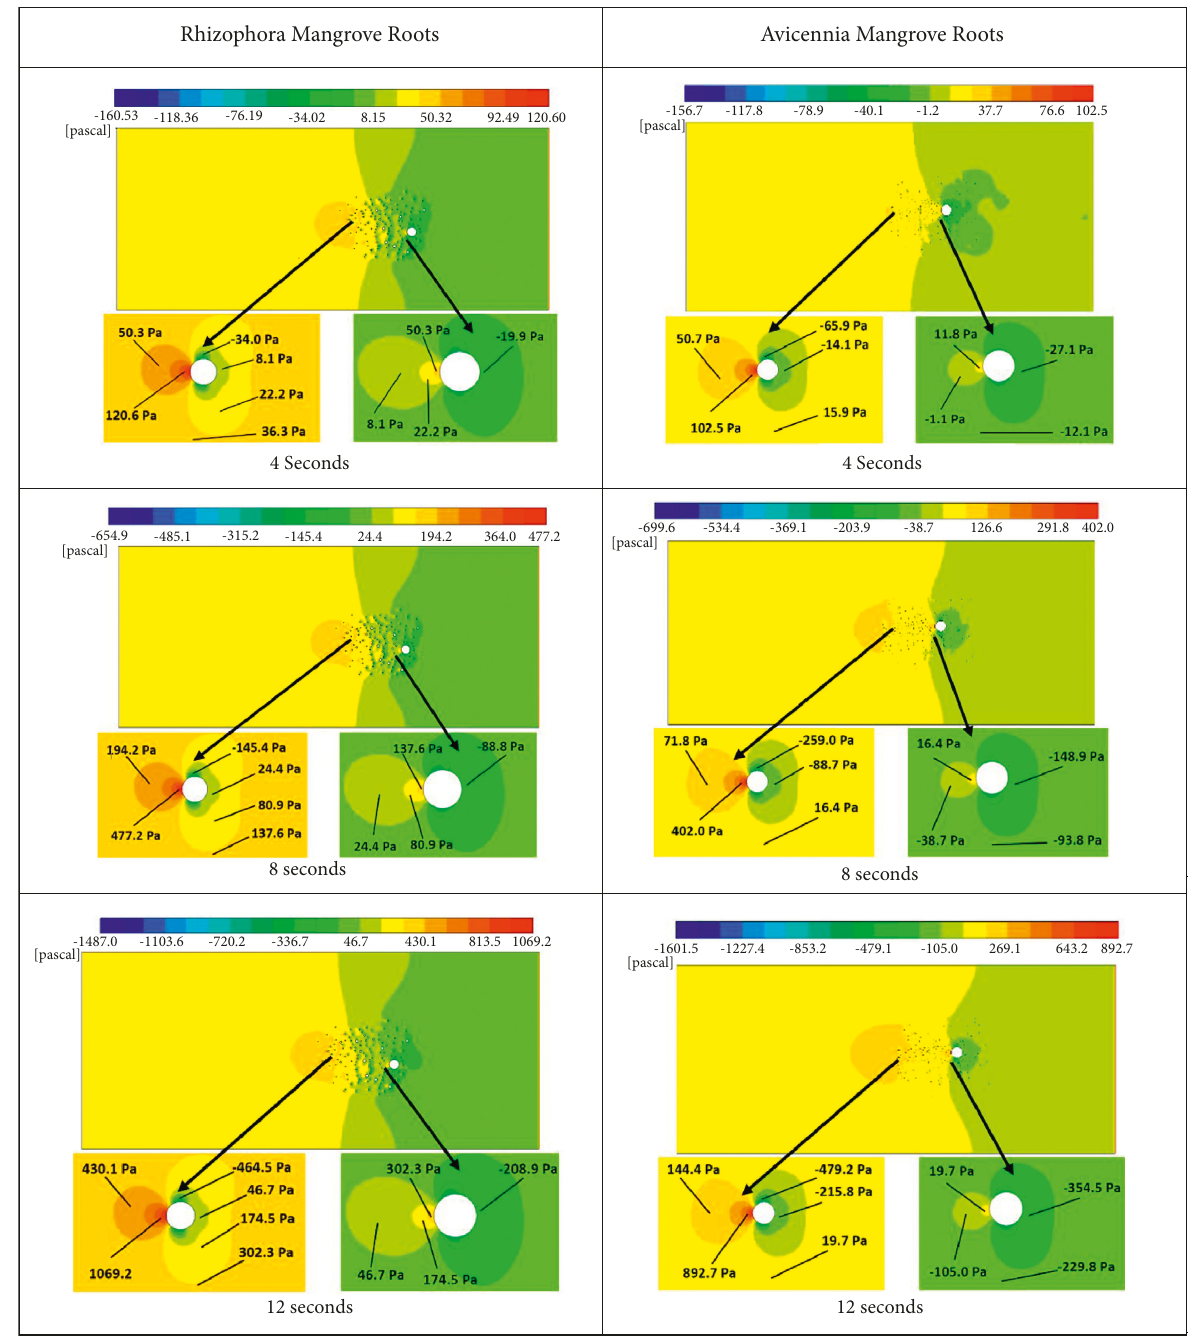
Figure 10: Static pressure distribution of incompressible unsteady air flow at time intervals of 4 seconds, 8 seconds, and 12 − 26.6 Pa, − 91.7 Pa, and − 250.3 Pa (green contour) and − 0.5 Pa, − 35.7 Pa, and − 50.5 Pa (light green contour). Table 5 represents the minimum and maximum pressure of flow around Rhizophora and Avicennia mangrove roots at time intervals of 4 seconds, 8 seconds, and 12 seconds with velocities of 10 m/s, 20 m/s, and 30 m/s, respectively. Figure 9 shows the pressure variations caused by Rhi- zophora and Avicennia roots in an x -axis cross section at different time intervals of 4 seconds, 8 seconds, and 12